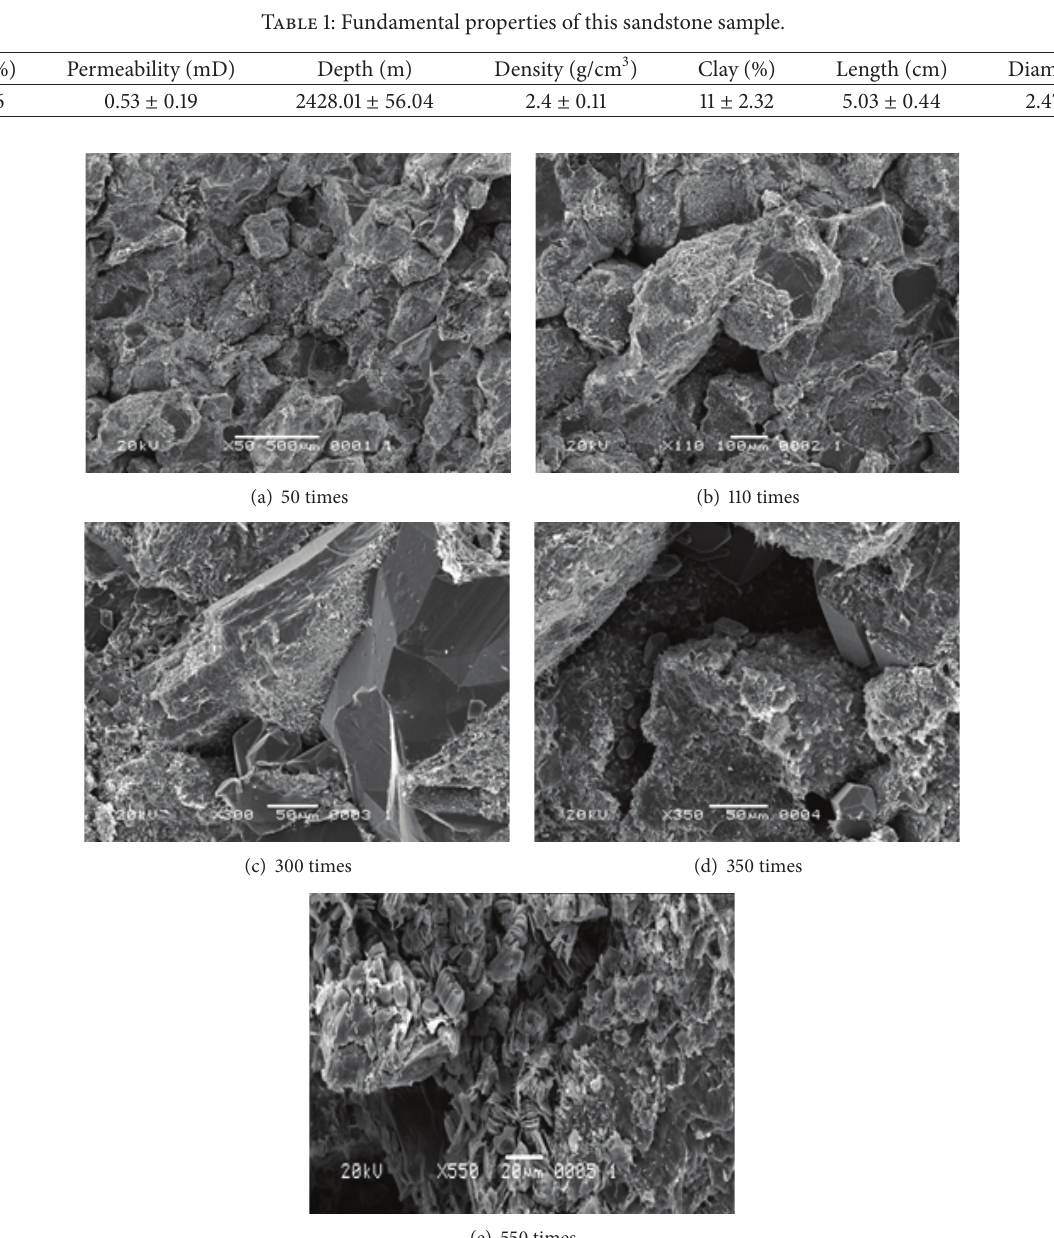
Figure 2: SEM images of this sample at different magnification